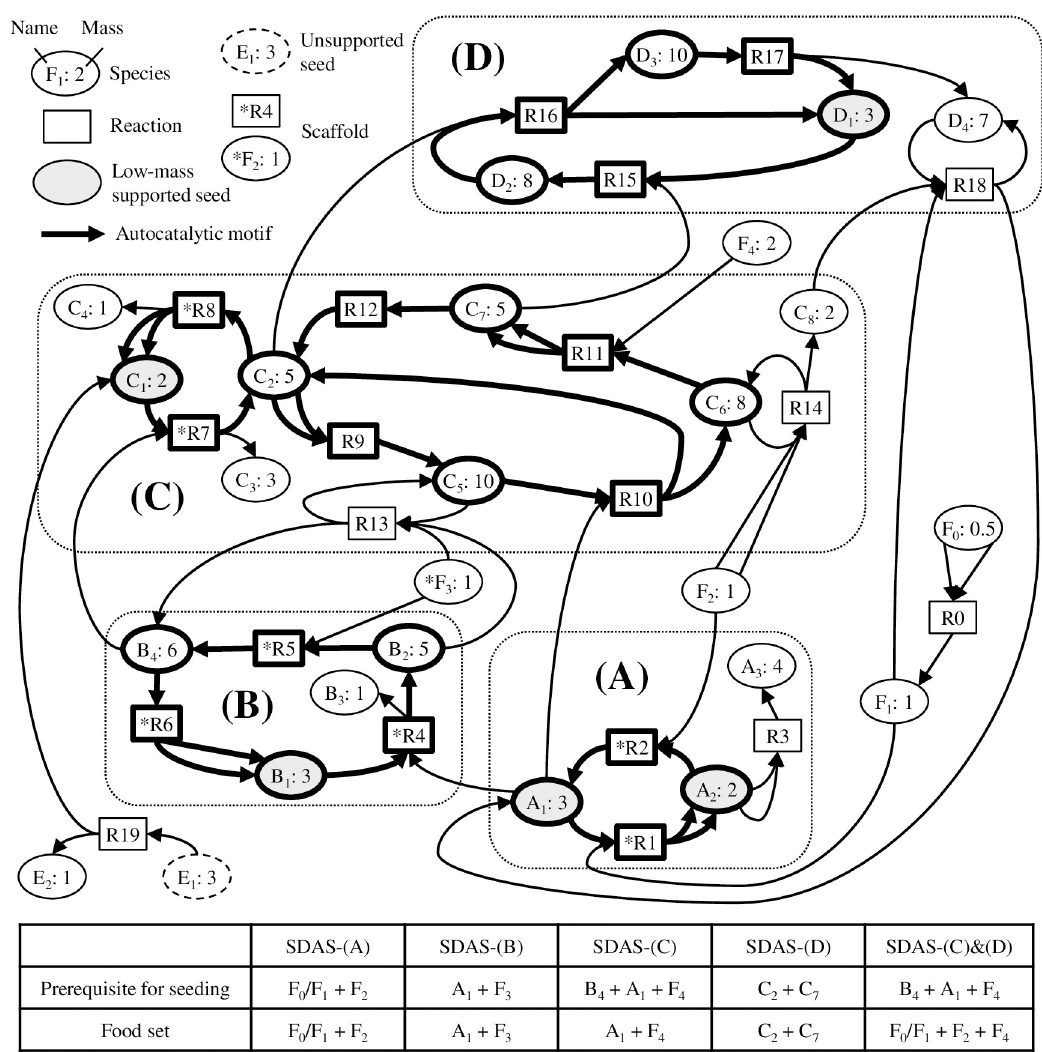
Fig 1. A hypothetical example of a SDAS-organized reaction network. Each species is associated with its mass, which can be viewed as a simple proxy for chemical complexity, where ultimate food and potential seeds all have mass � 3. This hypothetical example consists of four SDASs feeding on different sets of food. Each SDAS includes the member species of an autocatalytic motif and may also include species that are derived from the motif but are not part of the motif itself; for example, A 3 in SDAS-(A) and B 3 in